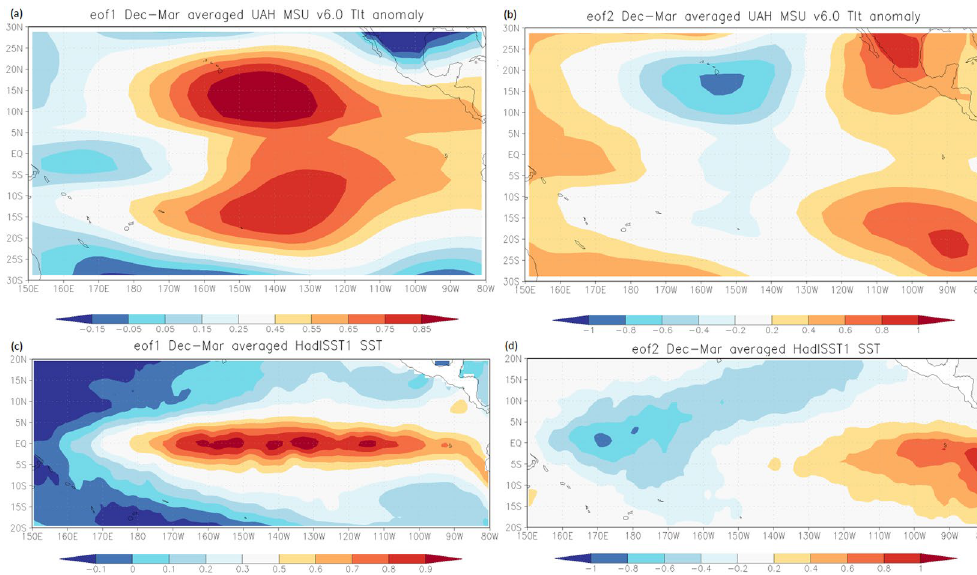
Figure 1. The respective spatial structure for EOF1 and EOF2 for the lower tropospheric temperature ( a ) and ( b ), and for the SST ( c ) and ( d ). The period is from 1979 to 2016 for the averaged months of December to March and the anomalies are with respect to 1981 to 2010. The EOF figure panels were generated using the online software from http://climexp.knmi.nl/eofform.cgi? UAH MSU v6.0 dataset is from http://www.atmos.uah. edu/data/msu/ and HadISST1 dataset is from http://hadobs.metoffice.gov.uk/hadisst/. However, caution in the interpretation should be taken as the HadISST1 dataset could be limited if utilized either for high resolution or spatial gradients and a minor discontinuity at the dateline can affect estimates of the variability in the